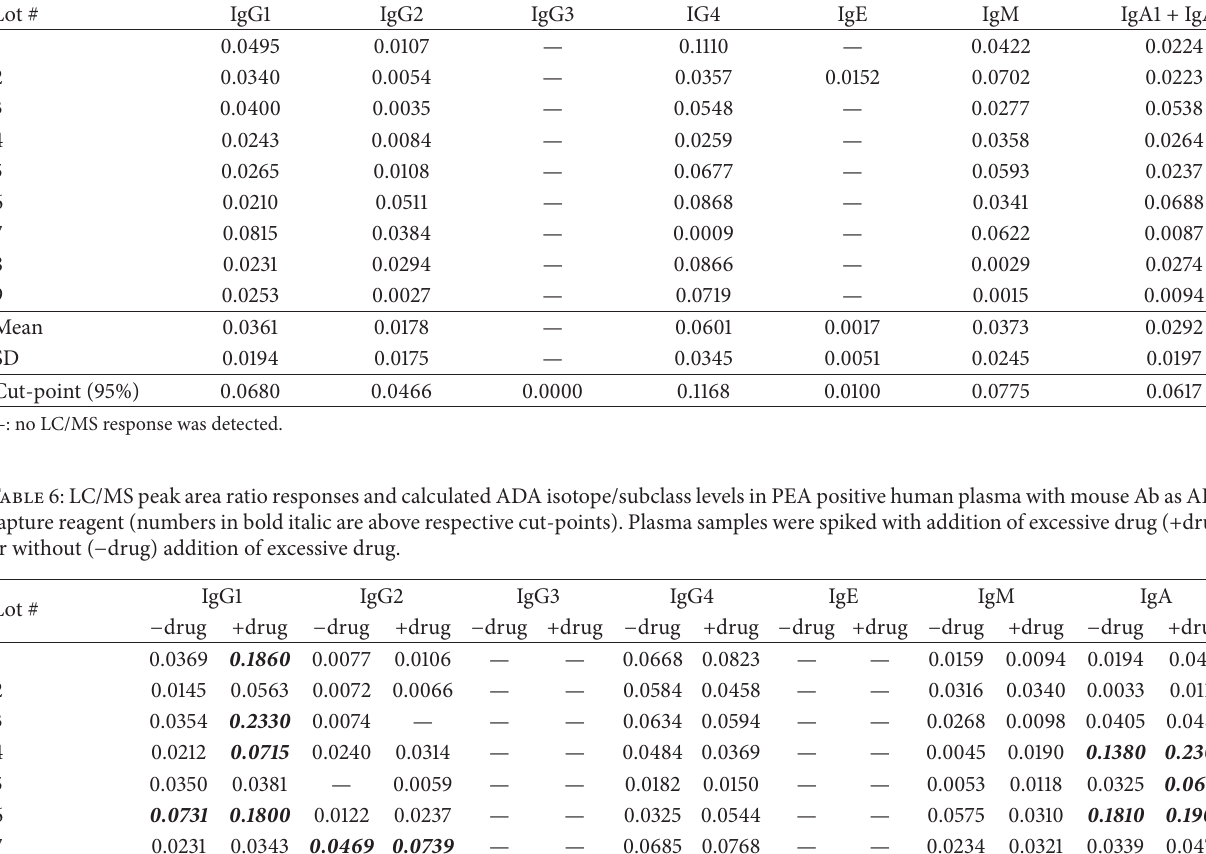
Table 5: LC/MS peak area ratio response and cut-points of ADA isotopes/subclasses in PEA negative human plasma with mouse mAb as ADA capture reagent.